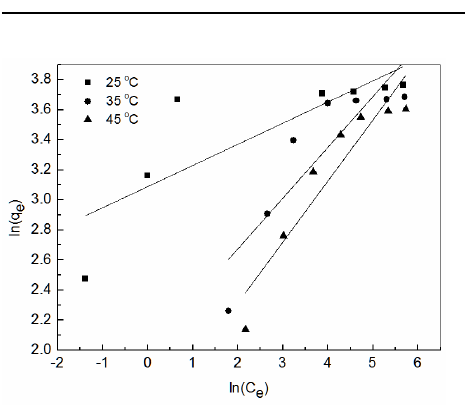
Figure 10. Linearized Freundlich isotherms obtained from Zn 2+ adsorption on amidoxime-modified polyacrylonitrile/fly ash composite.